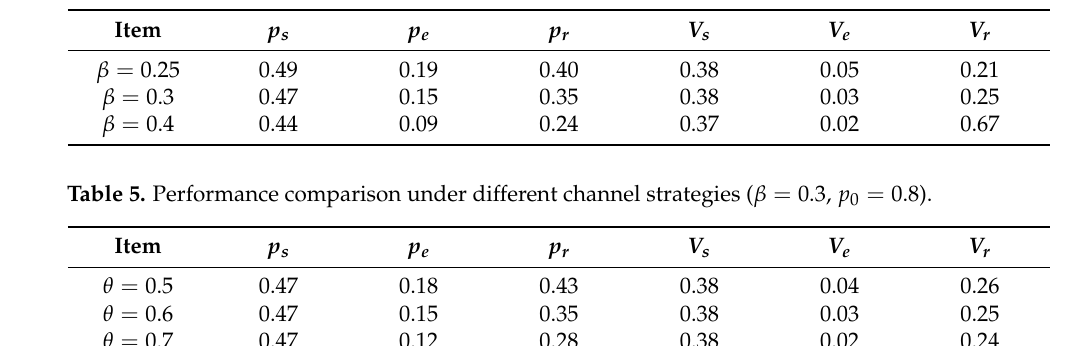
Table 4. Performance comparison under different channel strategies ( θ = 0.6, p 0 = 0.8).